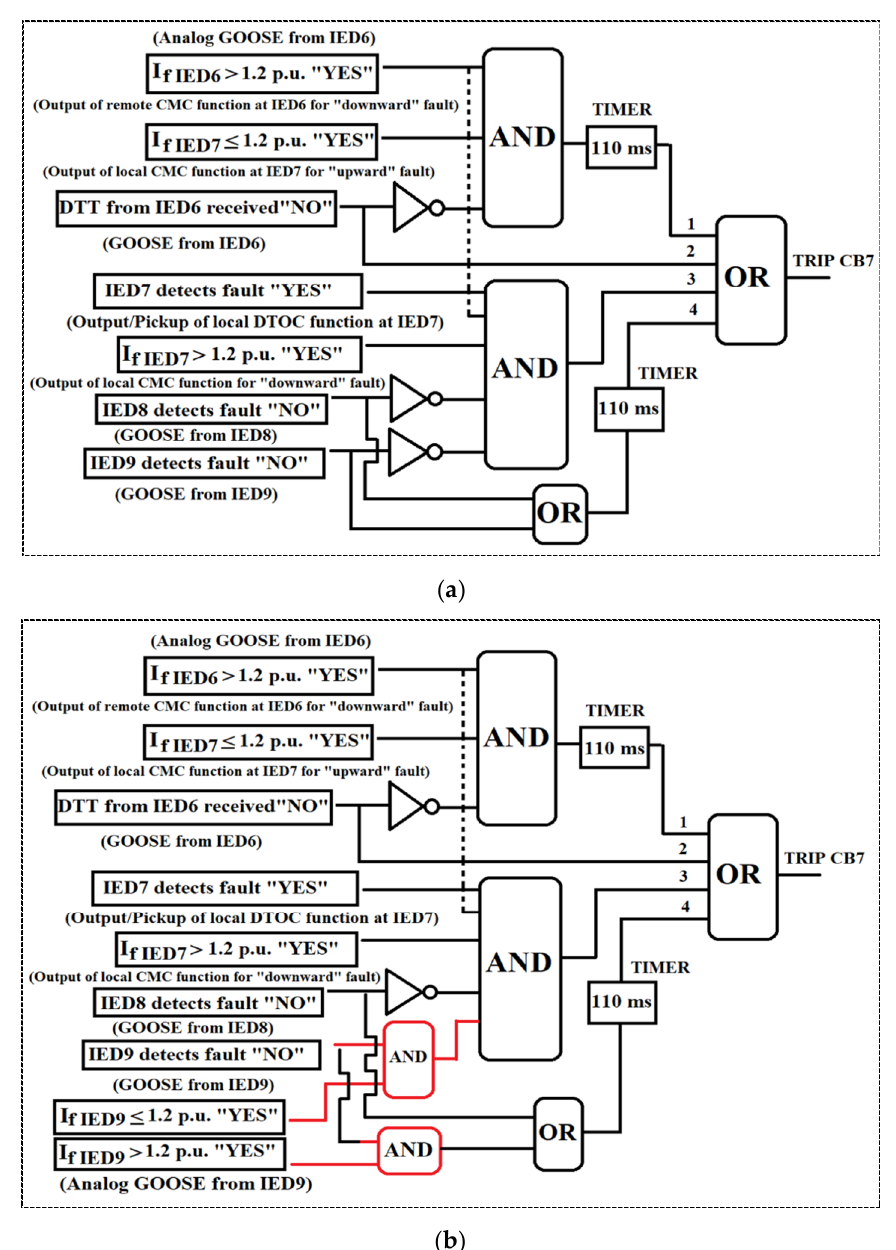
Figure 9. The application of the current magnitude comparison (CMC) function as GOOSE logic at communication-based IED7 to provide backup for the delayed/missing direct transfer trip (DTT) from the IED6 at a remote station bus when: ( a ) SG GM settings are used and ( b ) SG IM settings are used. (1) Backup for DTT from IED6, (2) normal DTT, (3) in-zone primary OC protection of IED7 and (4) time-delayed backup OC protection for IED8 and IED9.